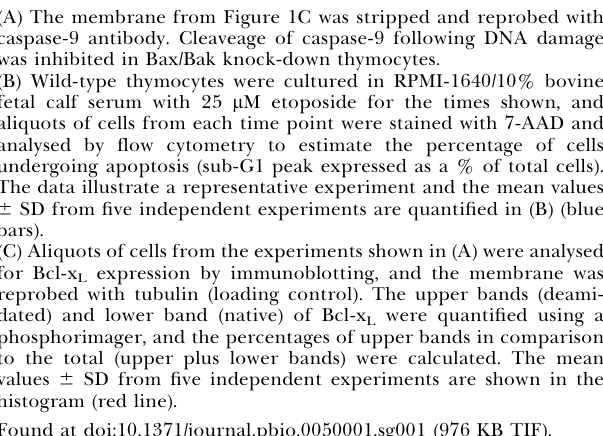
Figure S2. Deamidation Disrupts the Sequestration of BH3-Only Proteins by Bcl-x L (A) Puma binds to the native but not deamidated form of Bcl-x L . Either wild-type (1.5 3 10 7 , lanes 3 and 4) or pretumourigenic